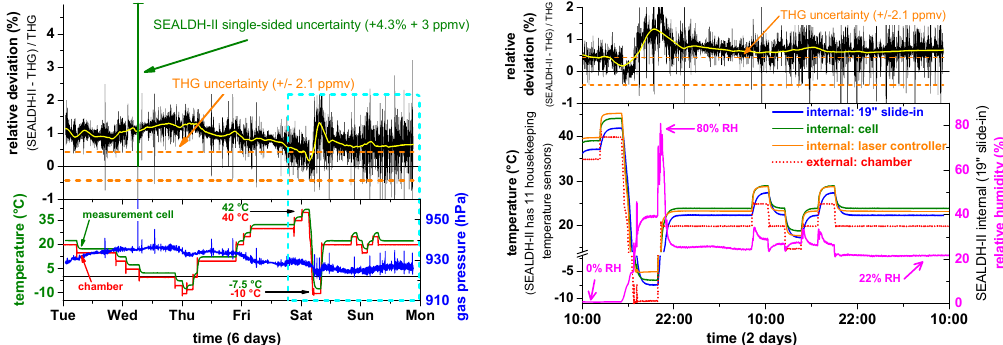
Figure 10. Validation results from the ambient temperature and humidity variation. Left: The black data show the relative deviation between the traceable humidity generator (THG) and SEALDH-II with SEALDH-II’s (green) and the THG’s (orange) uncertainty; Right: The bottom subplot shows the ambient (= internal chamber) temperature (red), gas temperature (green) and gas pressure (blue) in SEALDH-II’s measurement cell. The left subplot shows the zoomed section where also the ambient humidity (magenta) is varied.